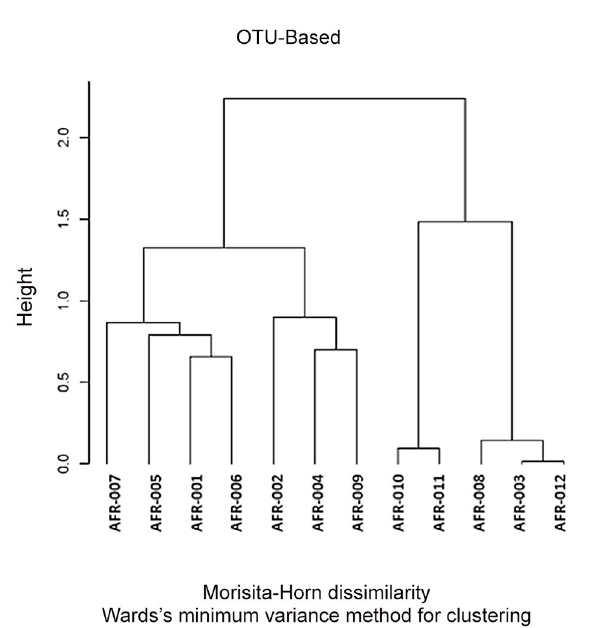
Figure 6. Dendrogram reflecting the healthy (AFR001-006) and colon polyps (AFR007-012) samples clustering based on the 454 pyrosequencing data analyzed at the Operational Taxonomic Unit (OTU: sub-genus) level.